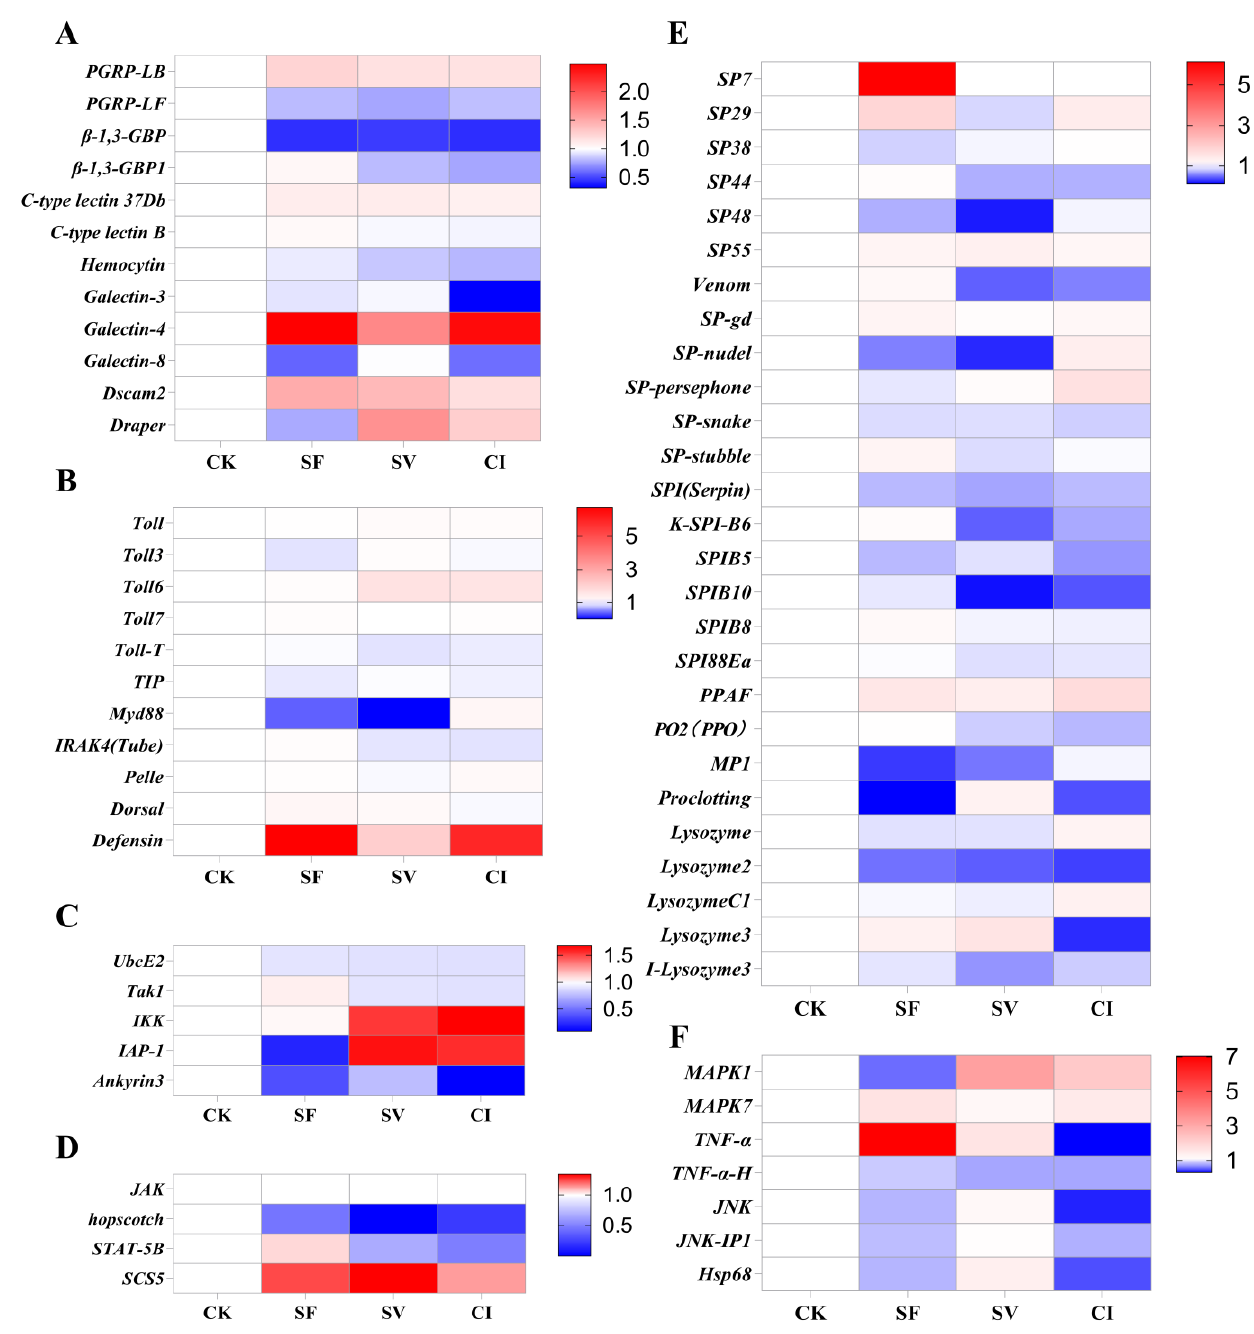
Figure 5. Relative expression levels of immune-related genes in RNA-seq. RRSV-free BPH were treated with Tween-80 (CK) or Metarhizium anisopliae YTTR (SF), and RRSV-carrying BPH were also treated with Tween-80 (SV) or M. anisopliae YTTR (CI). ( A – F ) respectively means the pathogen recognition receptors (PRRs), Toll pathway, immune deficiency pathway (IMD pathway), Janus kinase/signal transducers and activators of transcription pathway (JAK-STAT pathway), Serine protease cascade and Prophenoloxidase cascade (PPO cascade) and c-Jun N-terminal kinase pathway (JNK pathaway). The heatmap was constructed based on the relative expressions of immune genes compared to CK in RNA-seq. Different colors mean different multiples, and red indicates high expression and blue indicates low expression.